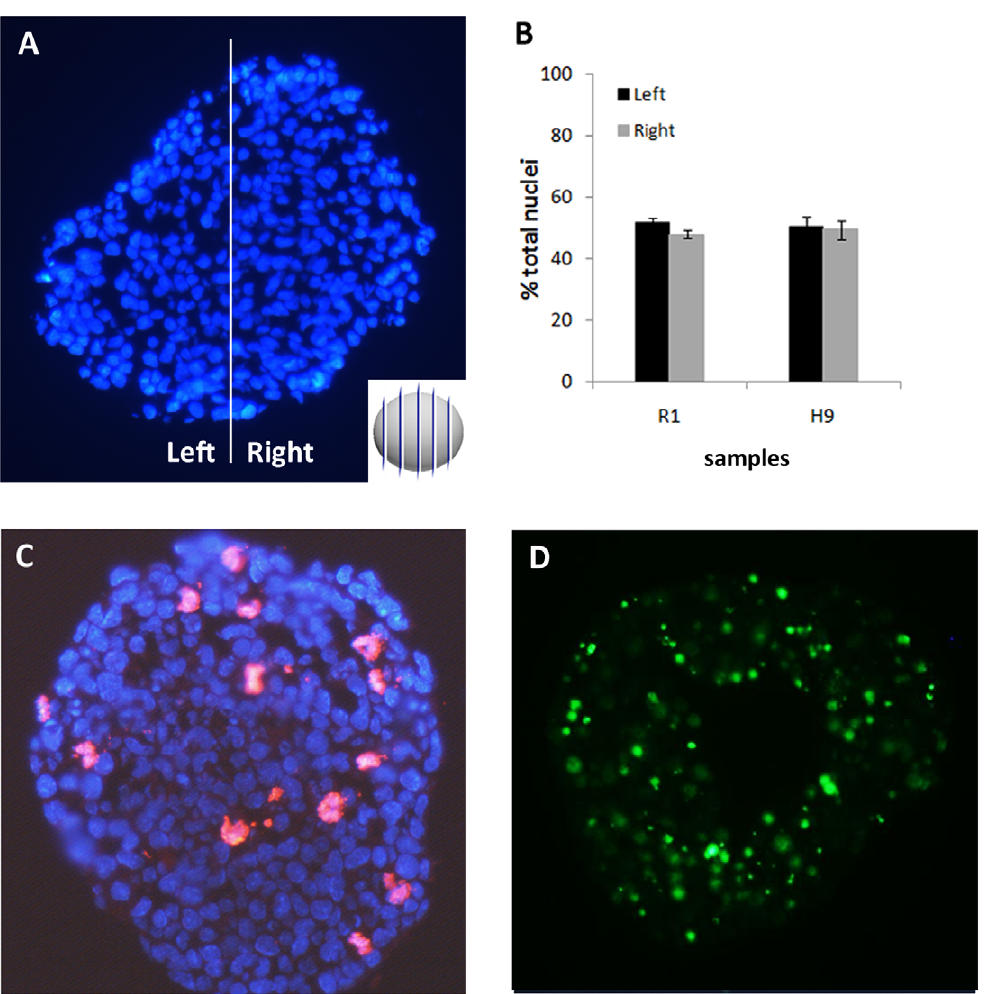
Figure 6. Atomic polarization is independent of cell density, proliferation and death. A) Example of a H9 14 days old neural induced embryoid body divided in half for nuclei quantification; B) Symmetry measure: left and right percentage of nuclei for neural induced R1 (n=5) and H9 (n=4) embryoid bodies; C) Example of PH3 staining (red) on a murine embryoid body; D) Example of TUNEL staining (green) on an H9 embryoid body. All DAPI (blue).